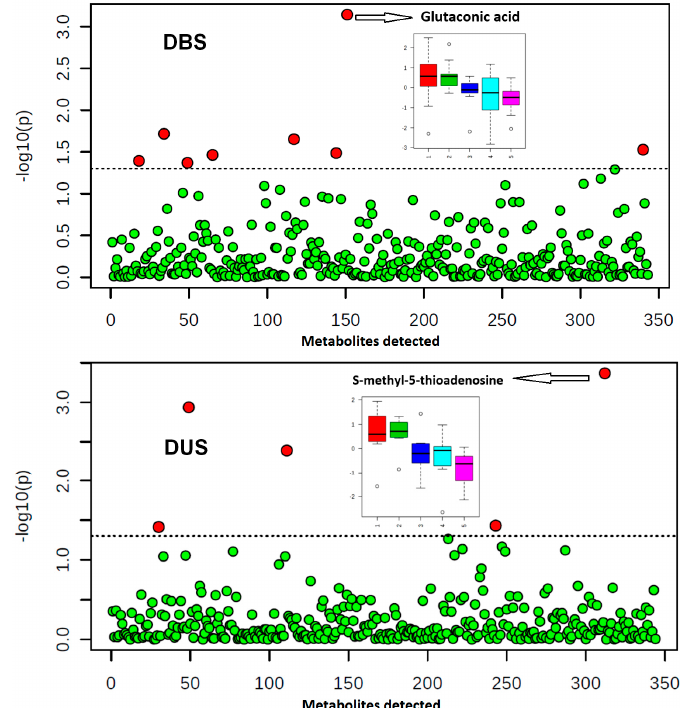
Figure 4. Temporal changes of metabolomes over days (morning fasting sample collection). Upper panel: DBS one-way ANOVA analysis results (subject = 16, days = 5, p value threshold 0.05). Lower panel: DUS one-way ANOVA analysis results (subject = 10, days = 5, p value threshold 0.05). X axis